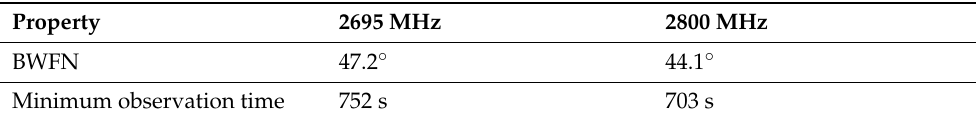
Table 7. Minimum observation times required for 2695 MHz and 2800 MHz based on antenna BWFN. Property